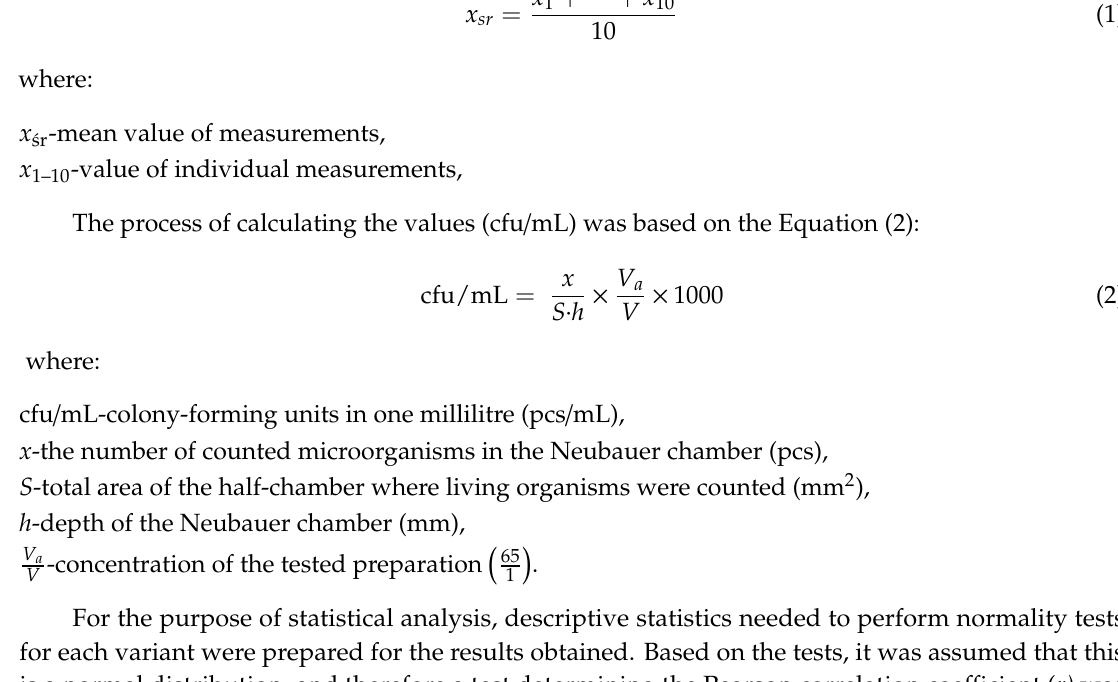
Figure 3. The influence of pressure on survival of cfu/mL of liquid for E Ż K025. Figure 4. The influence of pressure on survival of cfu/mL of liquid for E Ż K03.